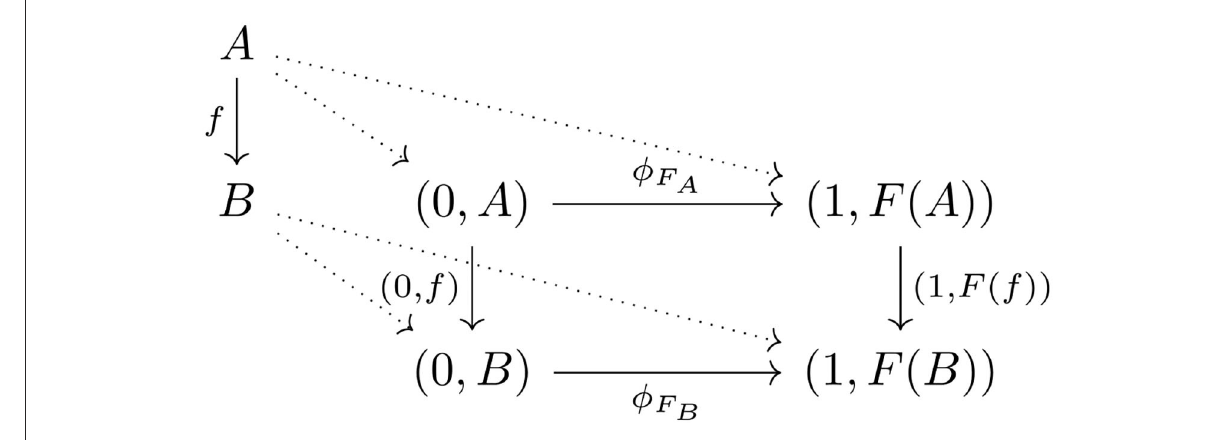
FIGURE10 Functor as natural